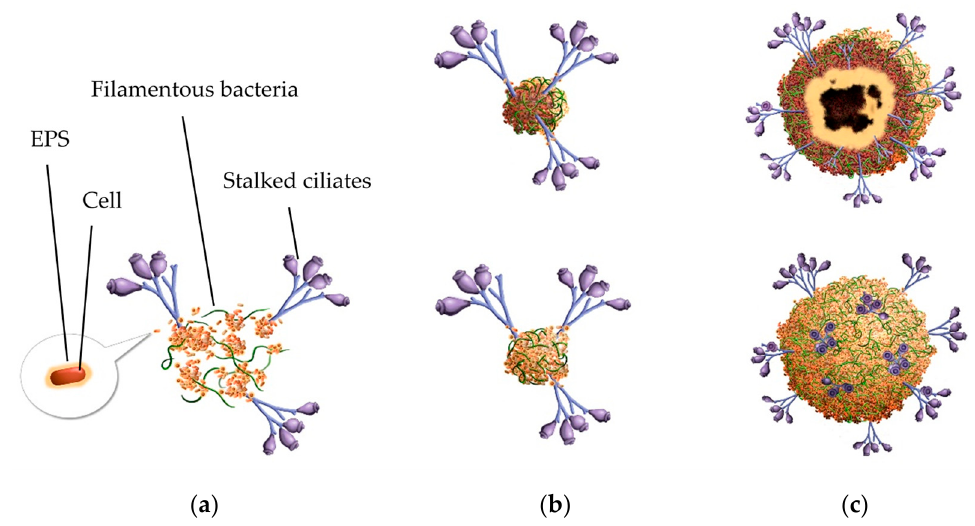
Figure 9. A hypothesis for the roles of filamentous bacteria and stalked ciliates in granule structure. ( a ) Floc sludge; ( b ) a small granule and its cross section; ( c ) a large granule and its cross section.